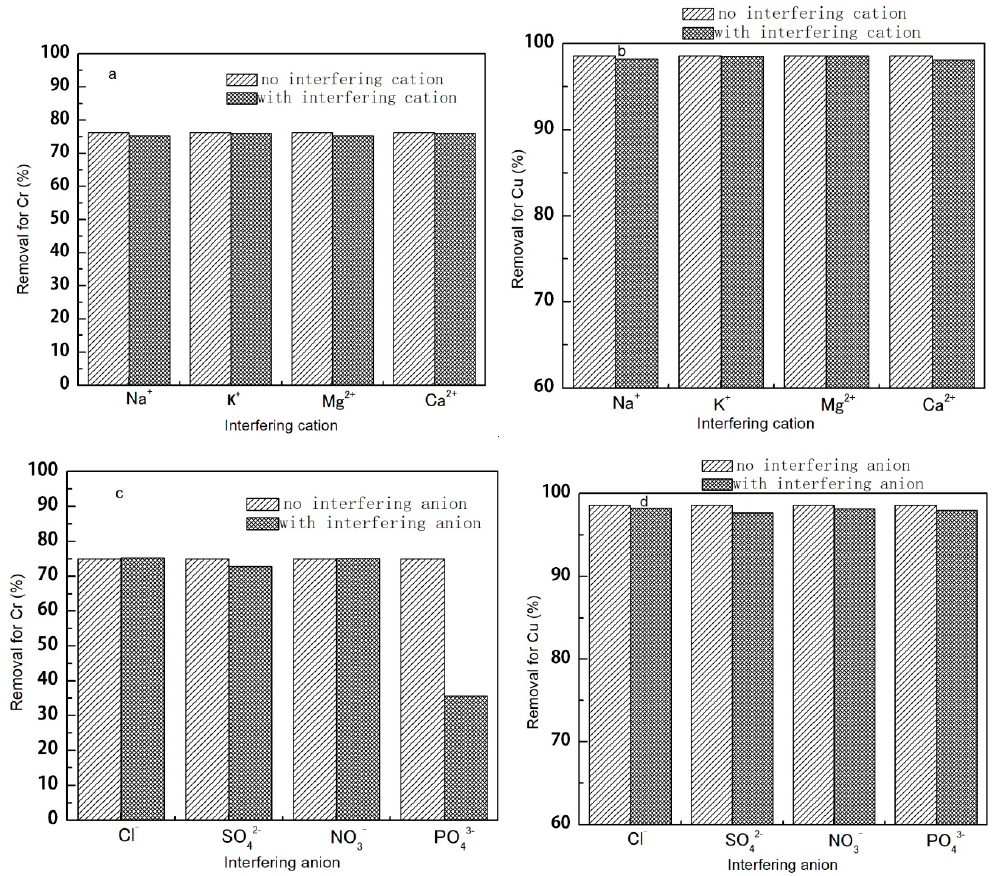
Figure 9. Effect of common ions on Cr(VI) and Cu(II) removal. ( a ) Cations’ effect on Cr(VI); ( b ) cations’ Figure 9. E ff ect of common ions on Cr(VI) and Cu(II) removal. ( a ) Cations’ e ff ect on Cr(VI); ( b ) cations’ e ff ect on Cu(II); ( c ) anions’ e ff ect on Cr(VI); and ( d ) anions’ e ff ect on